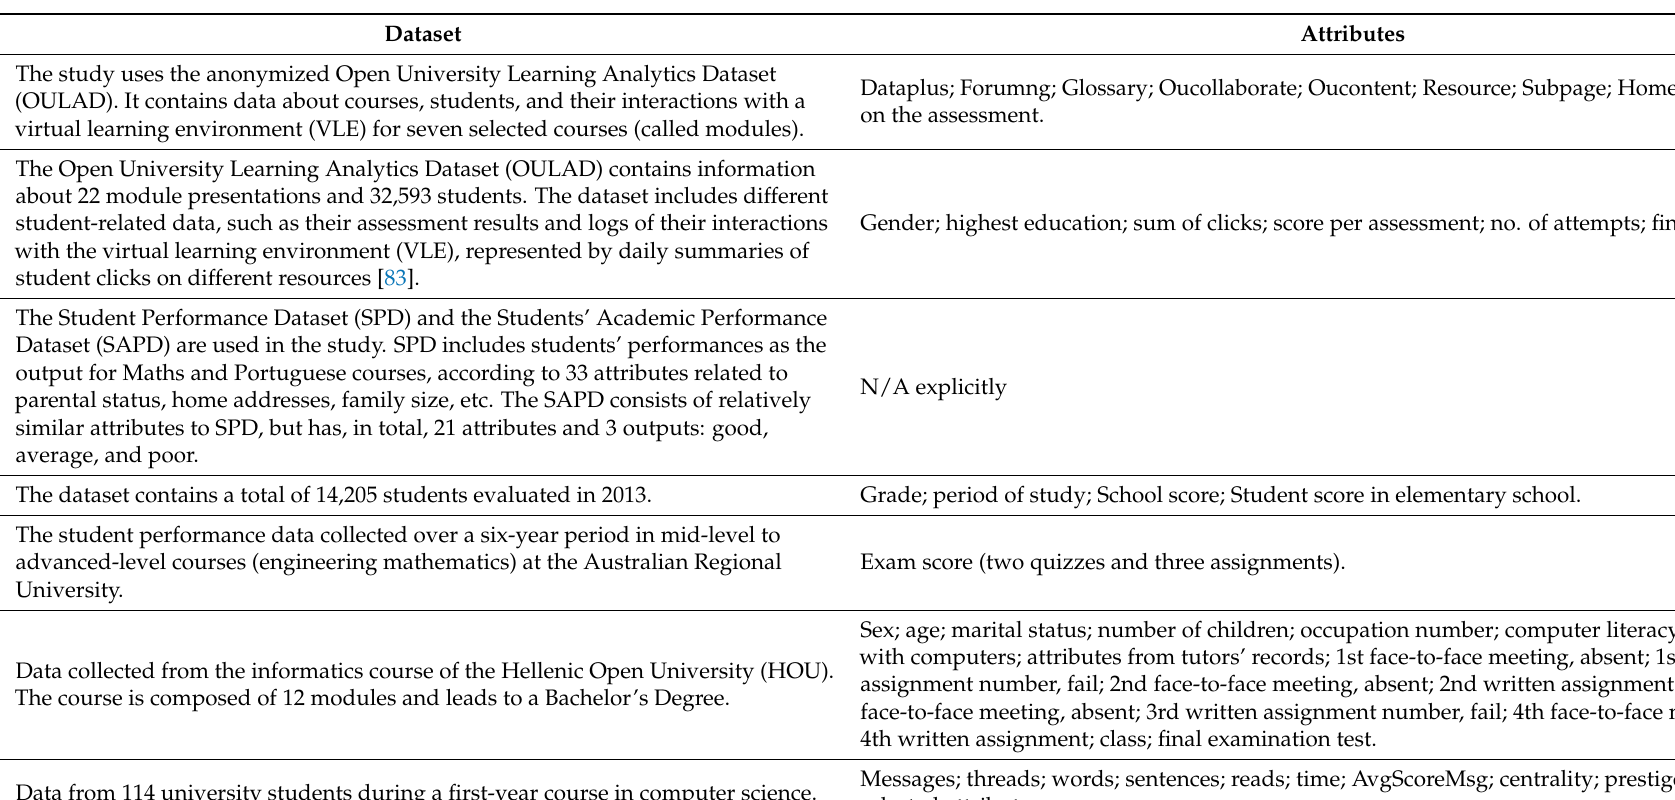
Table A2. Students’ performance predictor dataset and attributes used to train ML